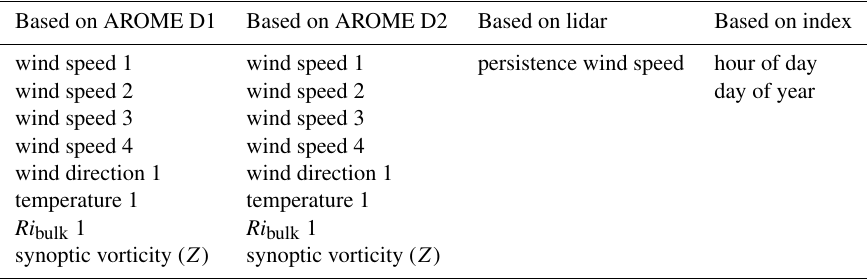
Table 1. All training features available for the RF algorithm. In the first column, training features based on the most recent forecast (D1) are listed, and in the second column, training features based on the forecast from the day before (D2) are listed (see Sect. 3.2.1 for details). The indices denote the grid points as marked in Fig. 1c. The persistence forecast for wind speed, listed in the third column, was generated using the lidar observations at 23:00UTC as described in Sect. 3.2.2. In the fourth column, training features based on index are listed. All forecasts for wind speed, wind direction and temperature are valid for hub height